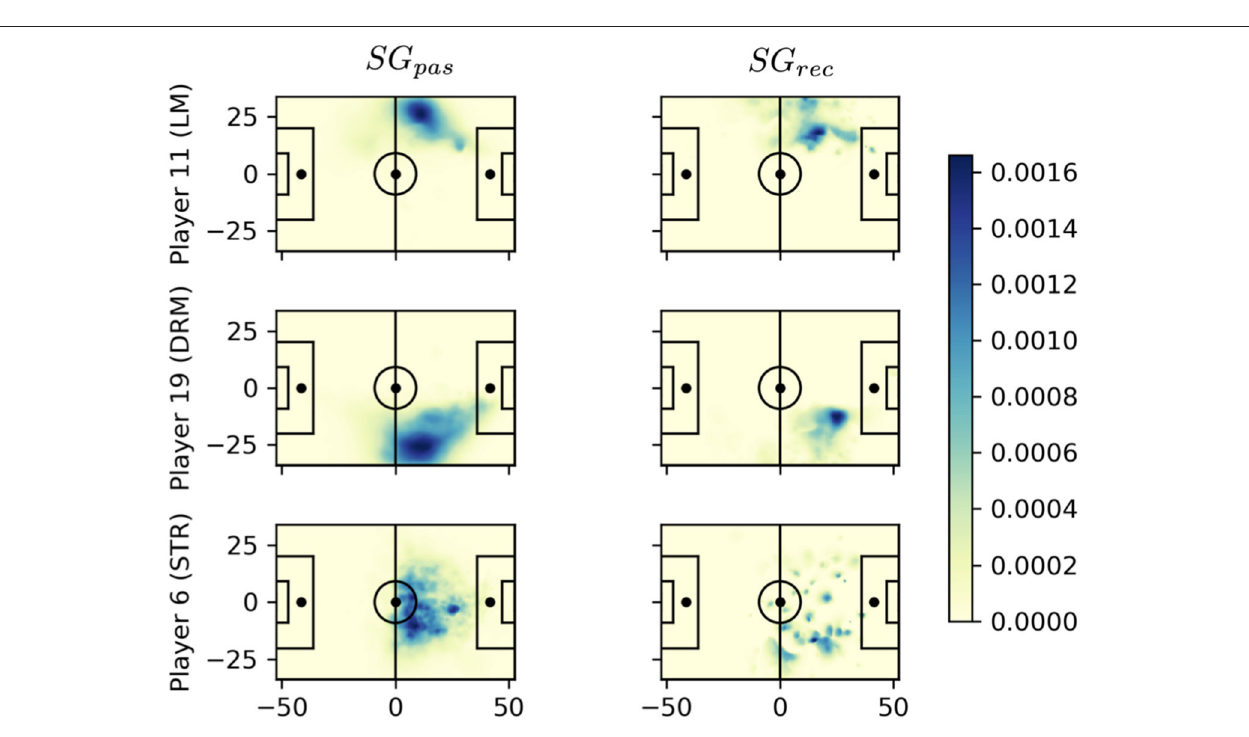
FIGURE 11 | Comparison of average space quality of the player at the time of all passes (left column) and at the time each player is the actual pass recipient (right column) . Playing direction is from left to right. The SG values in the color bar relate to the average space quality a player generates at a certain field position during all considered passing